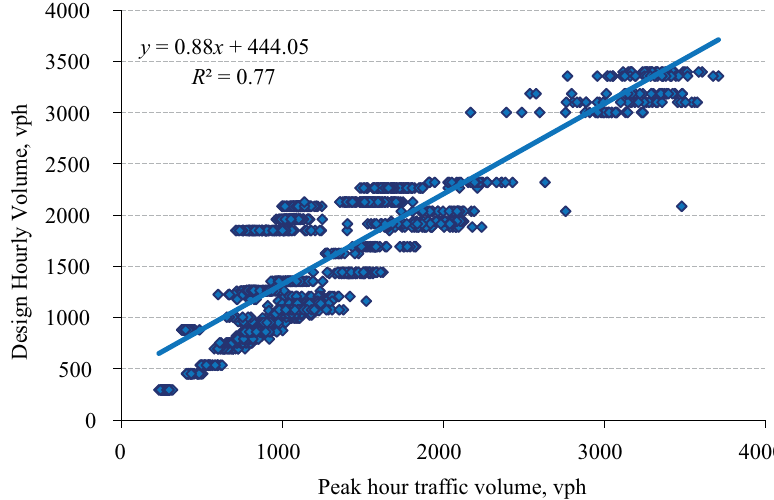
Figure 2. Graph of the relationship between the Design Hourly Volume and dominant perk